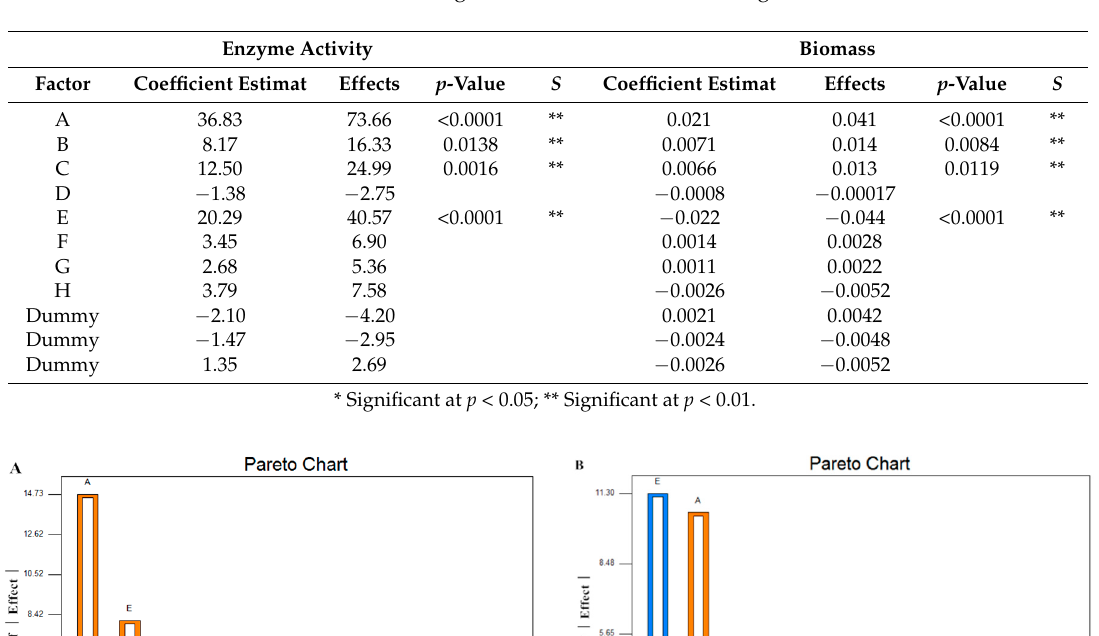
Table 3. The regression results for the PB design.